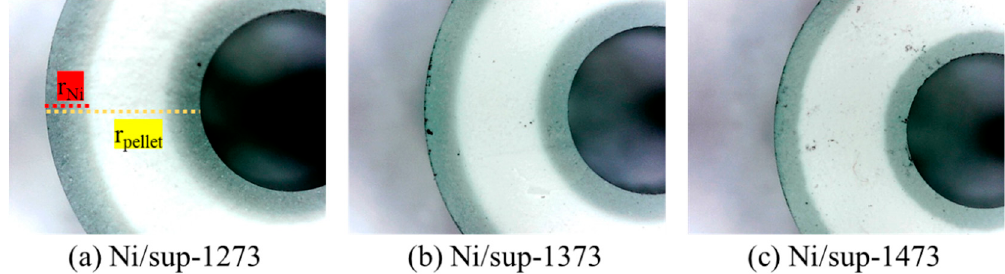
Figure 4. Cross-sectional image of the synthesized catalysts: ( a ) Ni/sup-1273, ( b ) Ni/sup-1373, and ( c ) Ni/sup-1473.